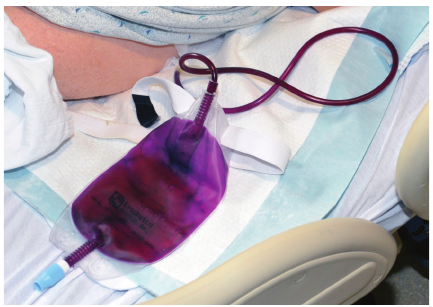
Figure 2: Dark purple discoloration of entire nephrostomy tube and urinary